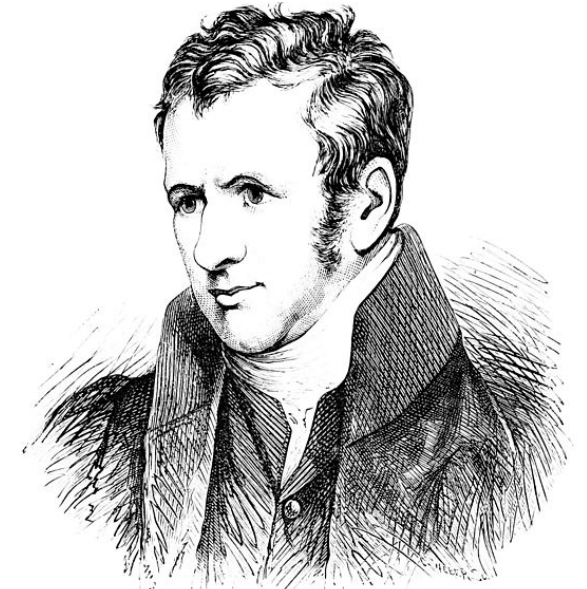
Figure 2. Sir Humphry Davy